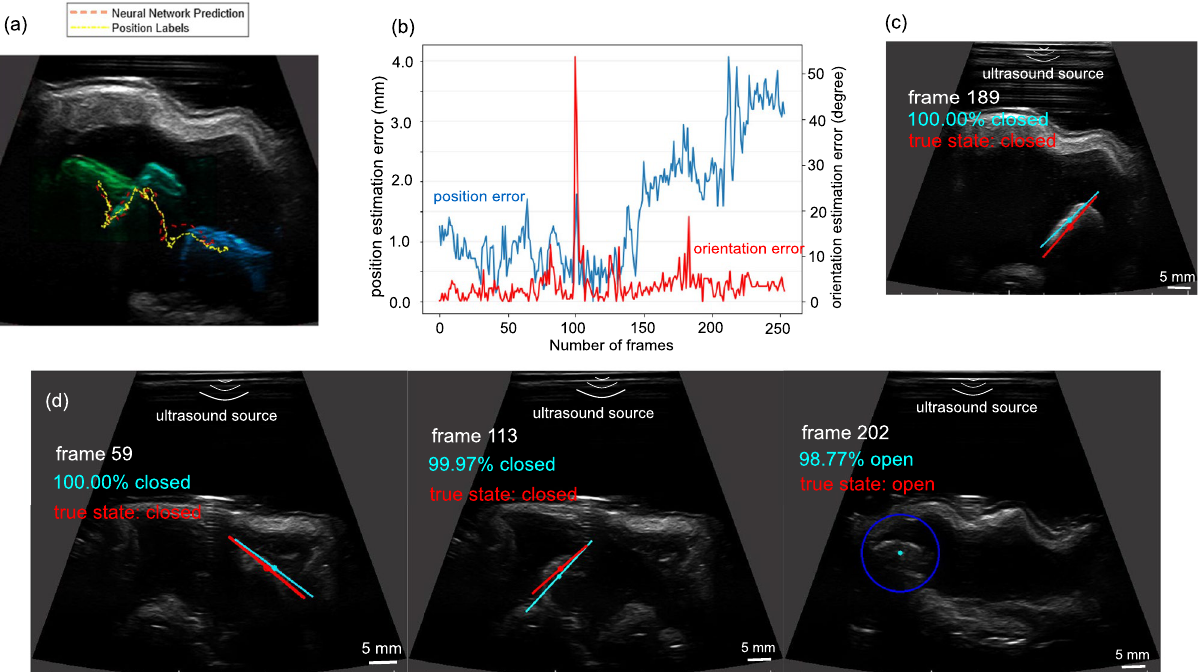
Figure 4. Ex-vivo pose estimation and mechanism state detection of the capsule. ( a ) shows the predicted versus the ground truth trajectories with a snapshot ( c ) from the video for the first trial, and ( b ) is the pose estimation error with respect to the frames in the first trial. ( d ) shows the snapshots from the video for the second mm, which corresponds to 12.1% of the body length. The ground truth and the predicted trajectories with the capsule in the initial, halfway, and final locations are plotted in Fig. 4a with the estimation errors in Fig. 4b. The successful rate of the orientation estimation is 96.9%, and the mean error is 3.5 ◦ , with a standard deviation of 4.7 ◦ . Angle ambiguity occurs at angles close to horizontal in a few frames, as shown in the supporting video. A sample test image is presented in Fig. 4c where the capsule is detected as “closed” with 100% accuracy through the entire locomotion sequence. In trial 2, to demonstrate the potential of our proposed method for tracking both the 2D pose and operational status of the wireless capsule for biopsy sampling in the GI tract in real clinical applications, the capsule was moved from an initial location to the final location actuated by a permanent magnet on top of the workspace and kept closed during locomotion. Then the capsule was actuated by bringing the magnet closer to it for cav- ity opening and biopsy sampling. In this trial, the capsule was moved in a section of the middle portion of the stomach with a thicker tissue and internal fat layers. Here, the ultrasound waves are attenuated and backscattered significantly from the surrounding tissues, rendering an image with low contrast and lots of speckle. The model successfully detects the capsule in most frames where the capsule presents low visibility and irregular geometries (Fig. 4d) except for a few frames (Supporting Video). In addition, the model detects the mechanism closed and lost state of the capsule correctly during locomotion. However, when the capsule gradually opens or the tissue occludes the cavity, the neural network model has difficulty with recognizing the open state and erroneously detects the closed state (Supplementary Fig. S4a). As the cavity further opens, the model can detect the state as “open” correctly, and the model trained on the closed capsule can localize the open capsule in the image (Fig. 4d). As shown in the supporting video, in this trial, the path is not smooth, and the capsule moves back and forth with some abrupt motions because the capsule was stuck and entangled by the internal thick tissue layer in the middle portion of the stomach. Ex‑vivo demonstration in a porcine colon. In addition to porcine stomachs, the trained neural network model was directly used to perform experiments in a porcine colon without further fine-tuning. The ex-vivo colon test images were generated using the same experimental setup, except that the porcine stomach was replaced with a section of colon tissue sample. Porcine colons feature large thickness of tissue layers, which renders low imaging contrast and occlusion of the capsule. Moreover, surrounding tissues and imaging artefacts bear high similarities with the capsule regarding the geometry and imaging contrast, which makes the accurate detection of the cap- sule more challenging. Despite of the difficult imaging conditions, our proposed method can still track the pose and status of the capsule successfully in this trial, especially in frames where the capsule presents a small region and low visibility due to occlusion, as shown in Fig. 5a. The model can also detect the “lost” status when the cap- sule is lost in the FOV, but has difficulty with recognizing closed capsule and provides the wrong state as “lost” in a few frames (Supplementary Fig. S4b). The complete tracking trajectory is shown in the supporting video.